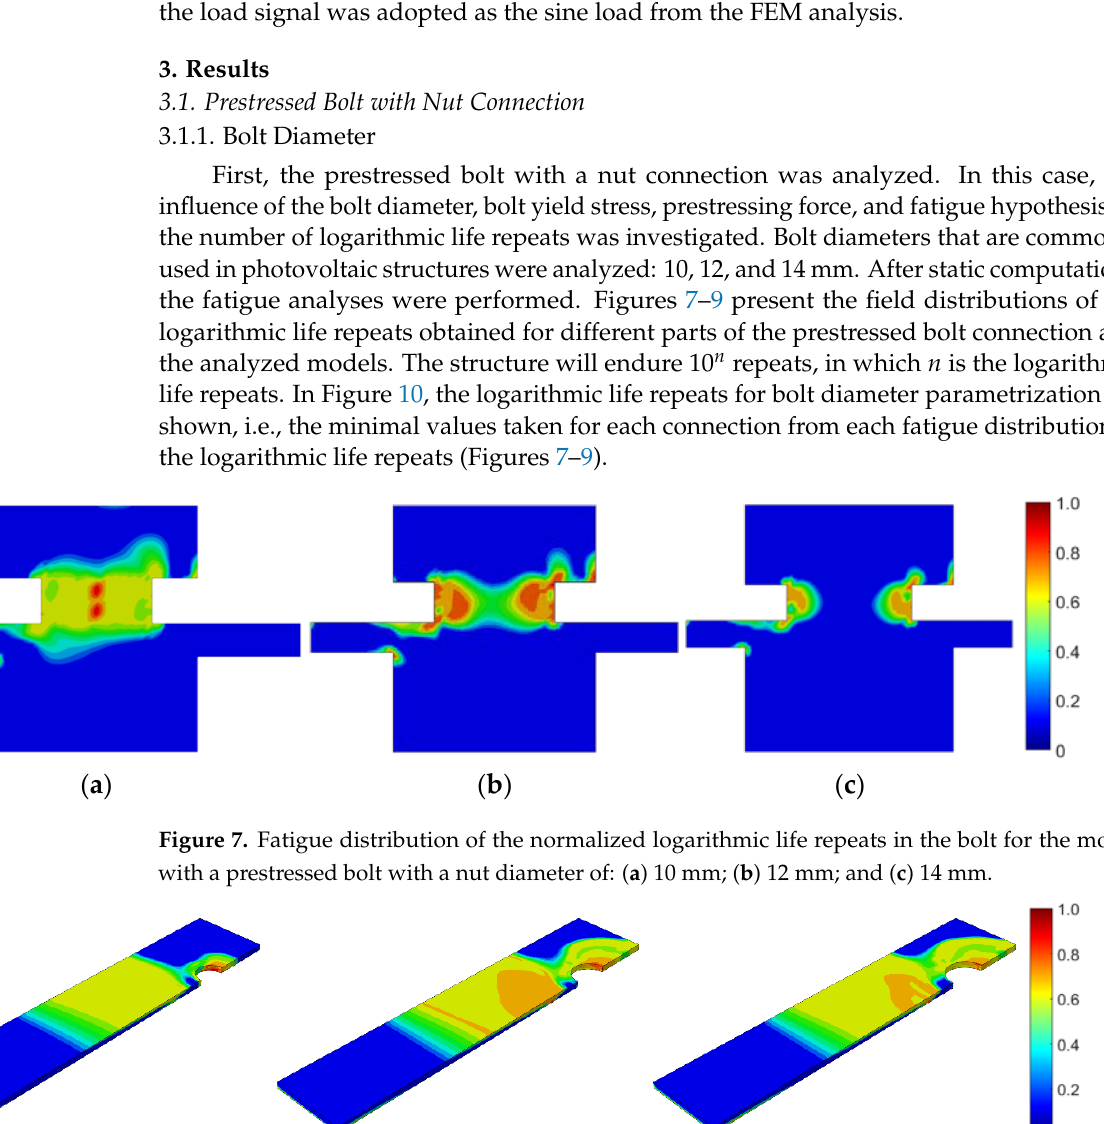
Figure 10. Number of logarithmic life repeats for diameter parameterization of the prestressed bolt with a nut. 3.1.2. Yield Strength of the Bolt The next parameter tested was the yield strength of the bolt with a nut. In this case, yield strengths corresponding to commonly used steel grades and several intermediate values were adopted. Figure 11 shows the number of logarithmic life repeats for the yield strength parametrization. The values presented are the minimal values of the logarithmic life repeats taken for each connection from the fatigue distribution (not shown).